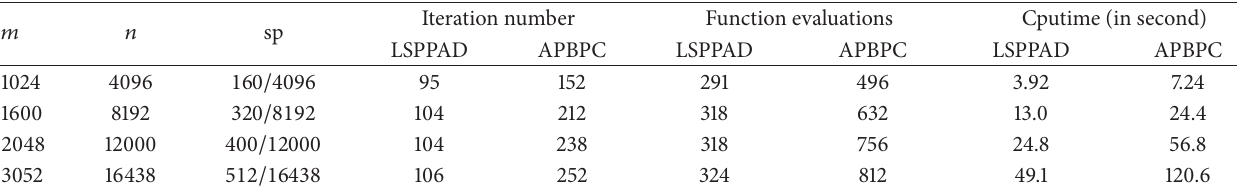
Table 1: Numerical results on compressed sensor